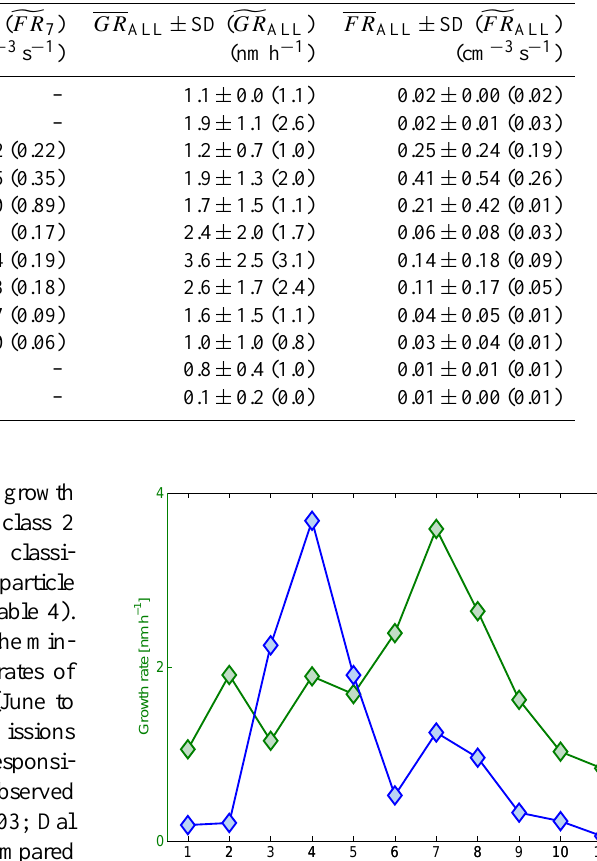
Figure 7. Monthly averages of particle growth rates (green) and formation rates (blue) for all class 1 and class 2 events. Note: parti- cle formation rates were calculated for the lowest observed particle size, which was not, however, in all cases the lowest measurable size of